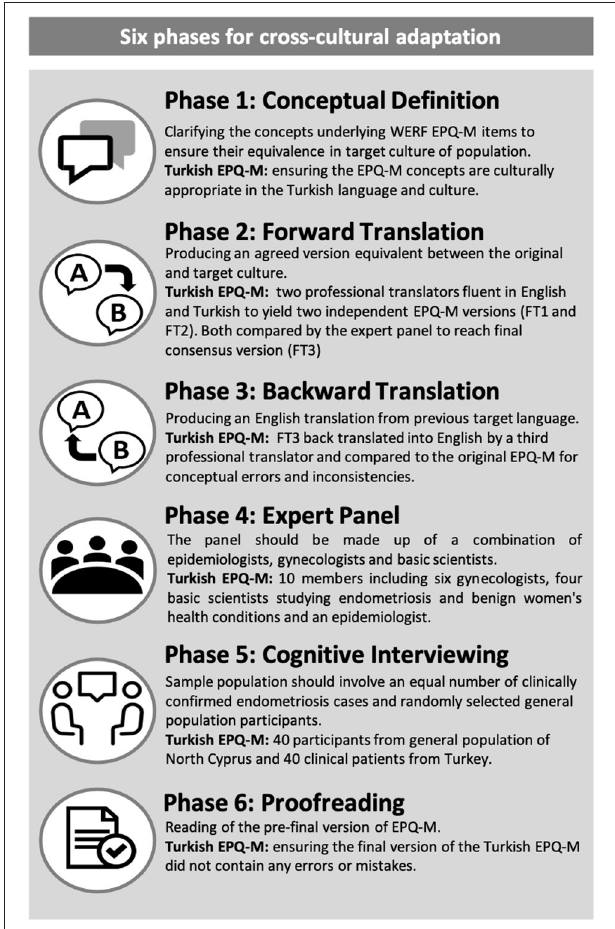
FIGURE 1 | Overview of the translation and cultural adaptation